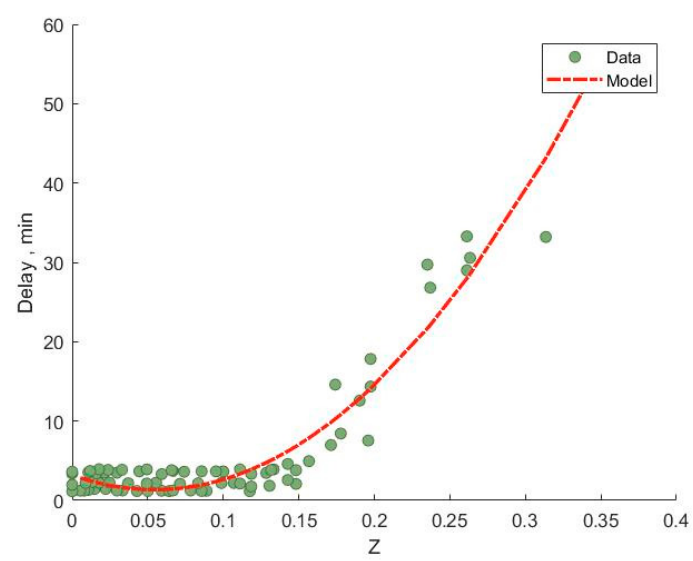
Figure 6. Simulation delay vs. adjusted model. Table 4. Evaluated scenarios.